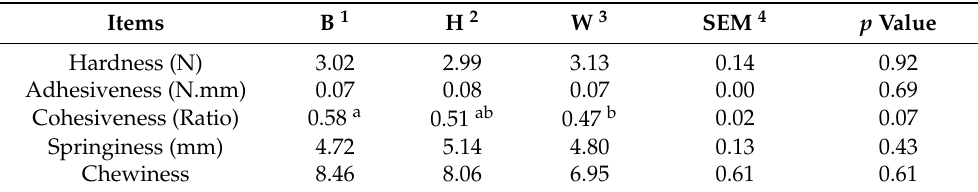
Table 3. Texture properties in egg yolks from three breeds.